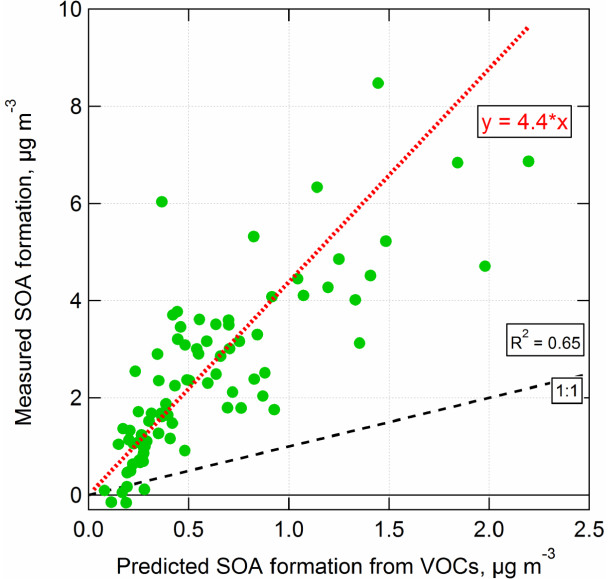
Figure 10. Measured vs. predicted SOA formation from OH oxi- dation of ambient air in an OFR using the OFR185 method. Only the range of photochemical ages with the highest SOA formation (0.4–1.5 eq. days) was used, and the LVOC fate correction was ap- plied. Predicted SOA formation was calculated by applying OA concentration-dependent yields (average of 12.5, 13.2, 13.8, and 3.2% for MT, SQT, toluene + p -cymene, and isoprene, respectively, with average OA concentration of 4.1µgm − 3 ) to VOCs reacted in the OFR (Henze and Seinfeld, 2006; Tsimpidi et al., 2010). The amount of reacted VOCs was estimated using OH exp and ambient VOC concentrations. If a nonzero y intercept is allowed, the regres- sion line becomes y = 5 . 0 x − 0 . 5.